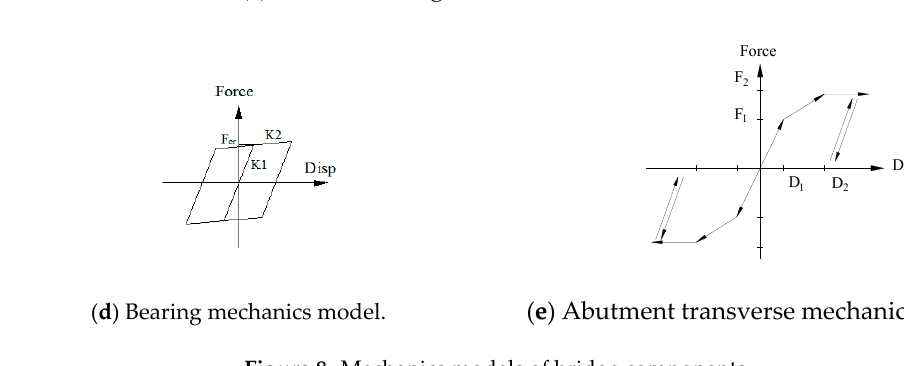
Figure 8. Mechanics models of bridge components. Table 8. Ground motion selection criteria.